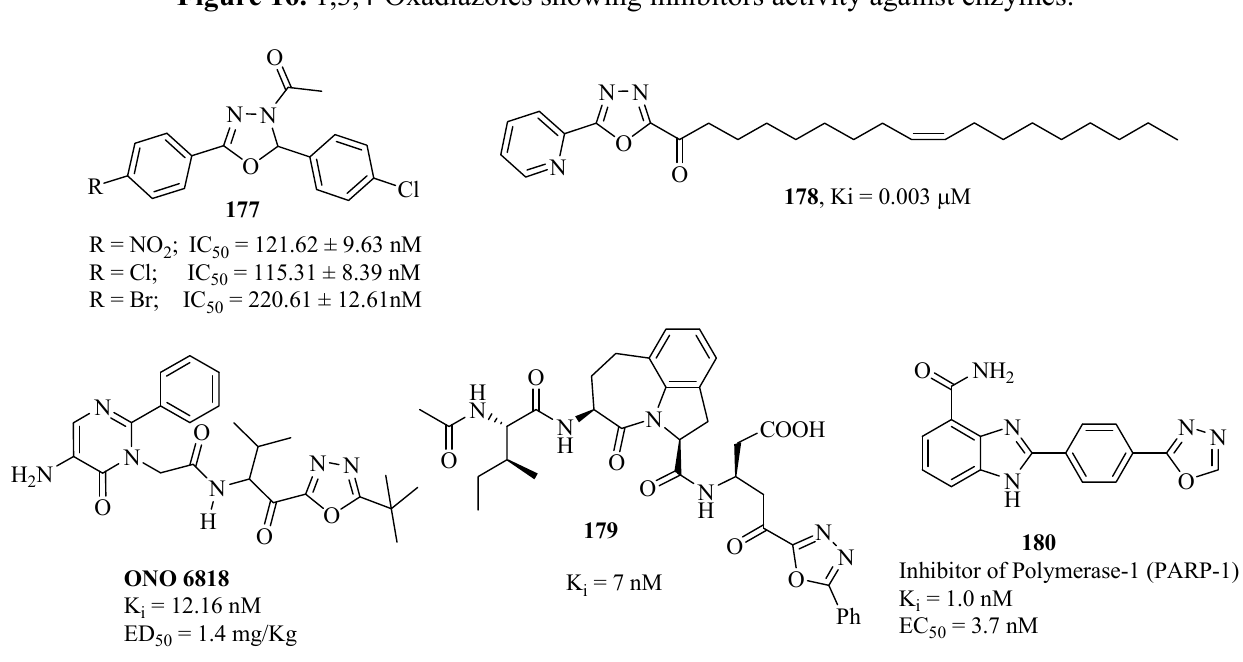
Figure 16. 1,3,4-Oxadiazoles showing inhibitors activity against enzymes.